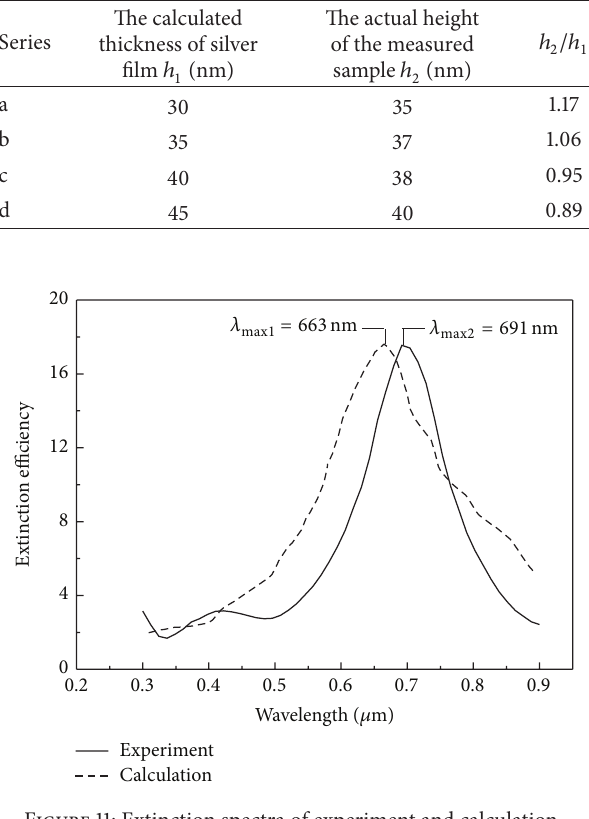
Figure 11: Extinction spectra of experiment and